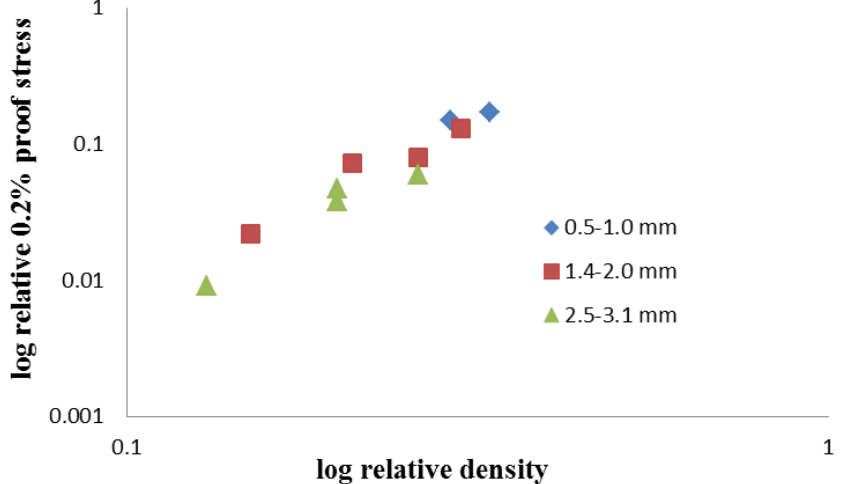
Figure 7. Log-log plot of relative proof stress and relative